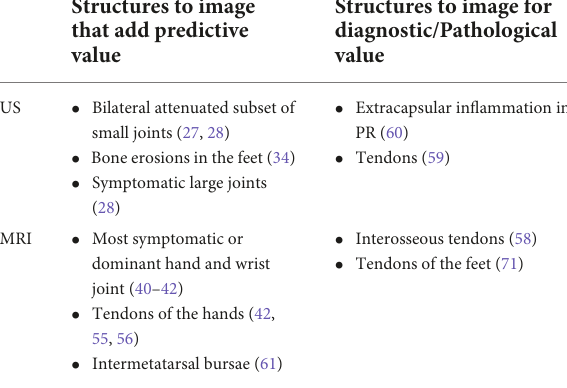
TABLE 3 A summary of which structures to image with MRI and US in individuals at risk of RA. Structures to image that add predictive value